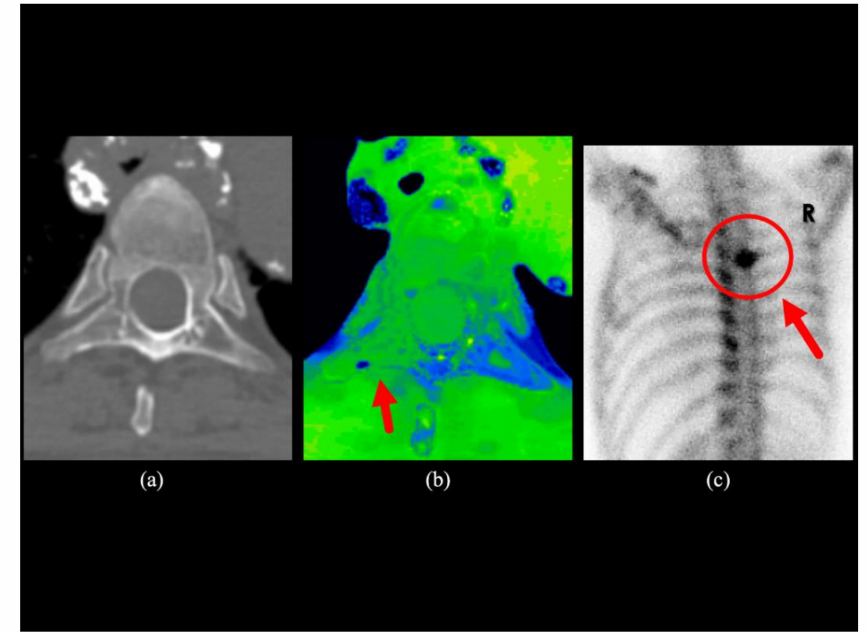
Figure 4. Clinical case 3. A man in his 70s with prostate cancer. ( a ) The transaxial image of the conventional CT image does not indicate an abnormal concentration in the fifth thoracic vertebra; ( b ) There is an increase in water density compared to the contralateral side in the right rib process of the 5th thoracic vertebra in the transaxial water-HAP image; ( c ) The posterior view of bone scintigraphy of shows metastasis to the right posterior element of the fifth thoracic vertebra. HAP;